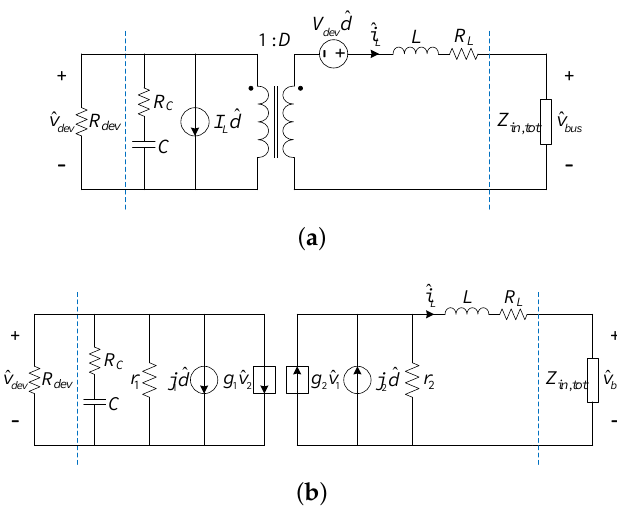
Figure 8. Averaged small-signal circuit of a bus-regulating converter when it works in ( a ) continuous conduction mode (CCM) or in ( b ) discontinuous conduction mode (DCM).